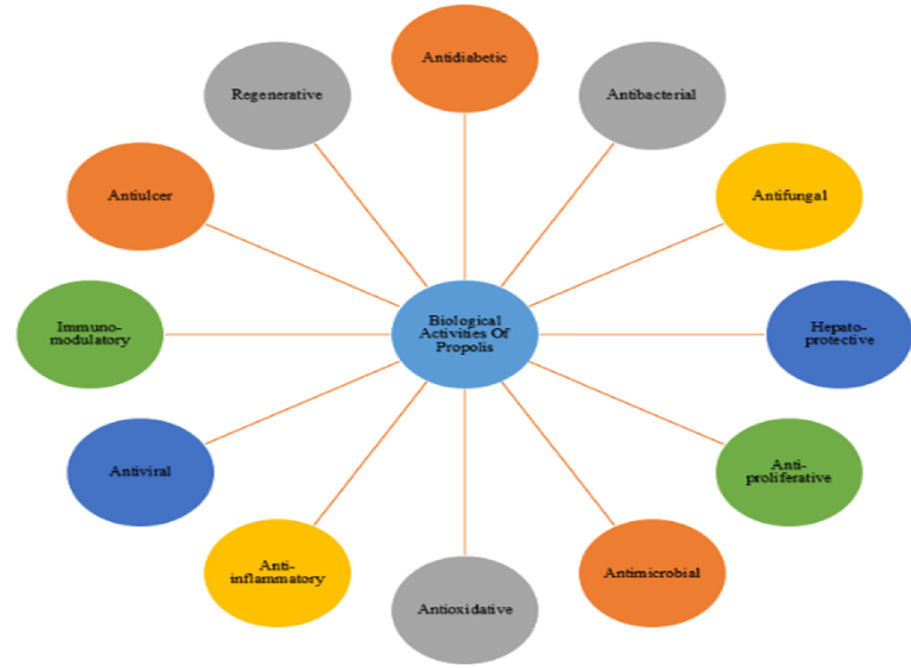
Figure 1: Biological properties of propolis.